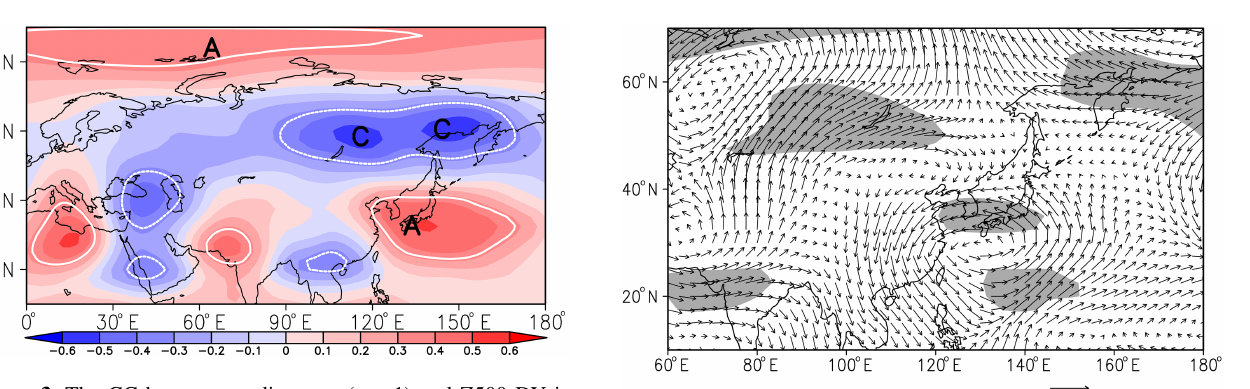
Figure 3. The CC between predictor x 1 ( ×− 1) and Z500 DY in winter from 1980 to 2013. The white curves indicate that the CC exceeded the 95% confidence level. A and C represent anticyclone and cyclone, respectively.